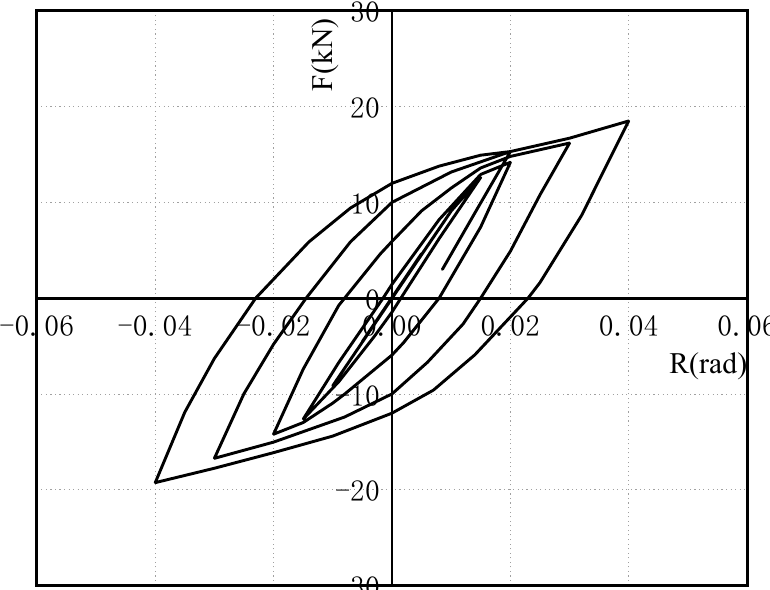
Figure 10. Hysteretic curve.